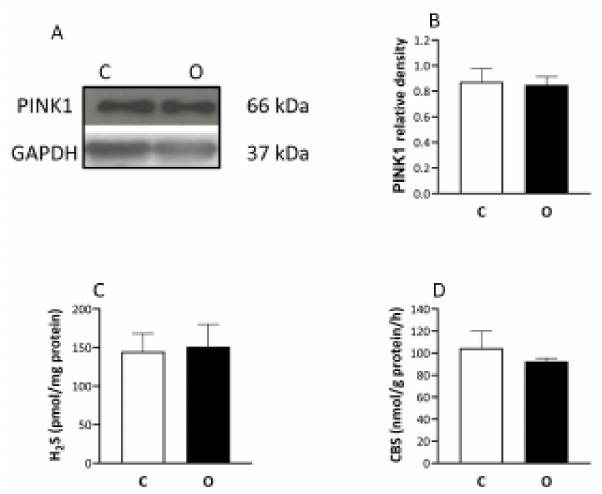
Figure 6. The levels of PINK1, H2S, and CBS did not change the muscle hypertrophy. The unaltered levels of PINK1 and H 2 S, as well as cystathionine- β -synthase (CBS), rules out the significant modu- lating role of mitophagy or H 2 S contribution through activation of SIRT1 in increased muscle mass. ( A ) panel shows the selected immunoplot signals, and ( B – D ) panels show the densitometric results of nine samples in each group. C: control group, O: Overloaded group, n = 9, Results are expressed as mean ±